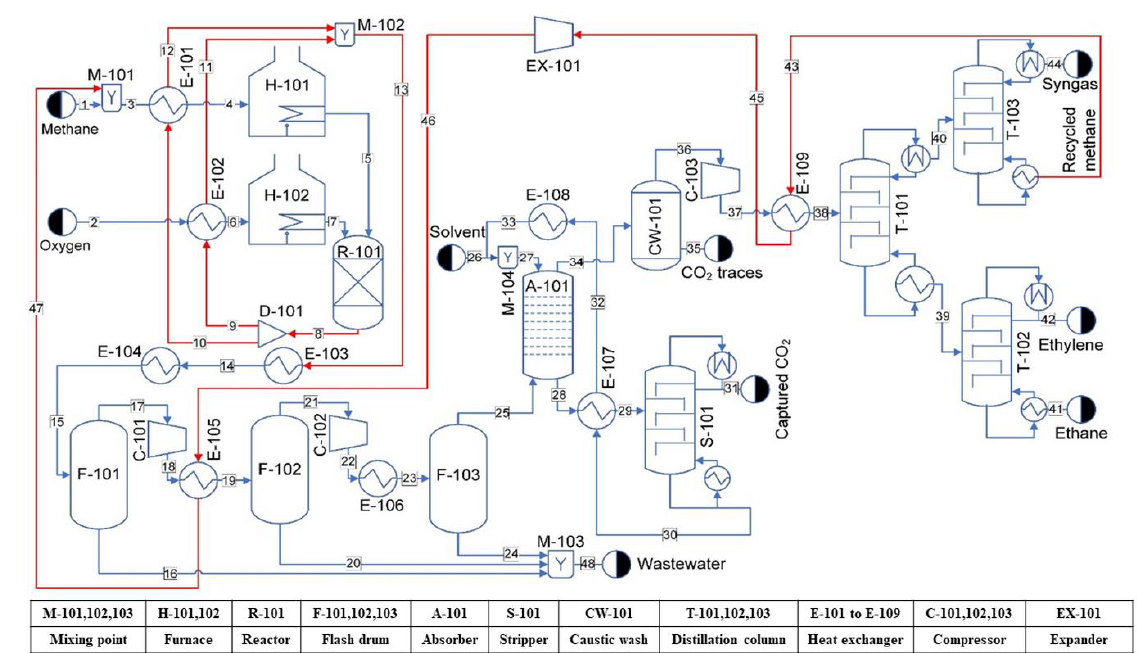
Figure 9. Developed process flow diagram of the OCM plant after heat integration.